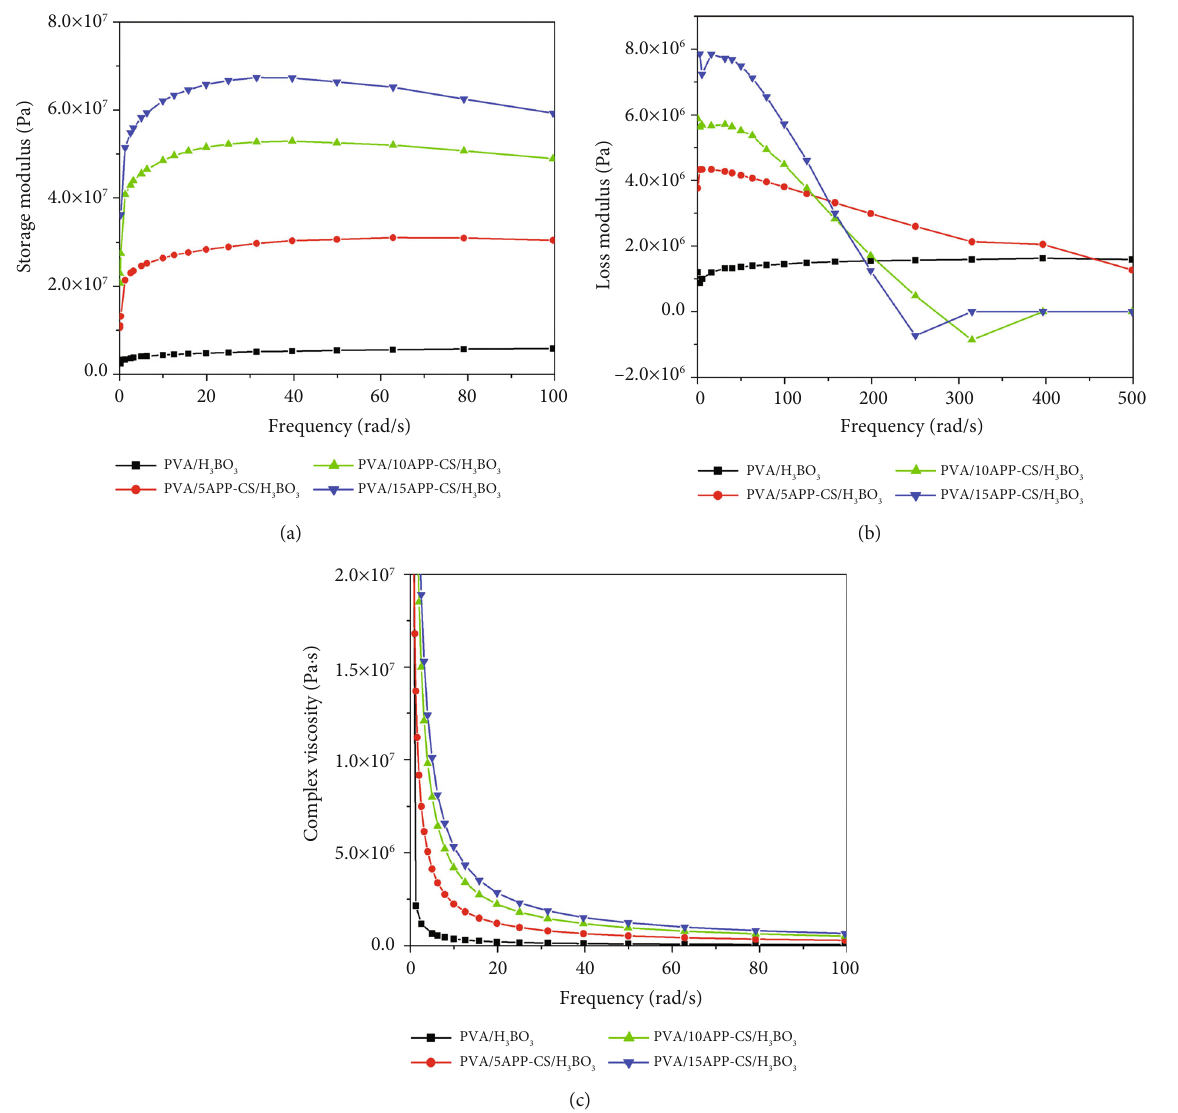
Figure 5: Dependence of (a) G ′ , (b) G ″ , and (c) η ∗ on frequency for the PVA composite